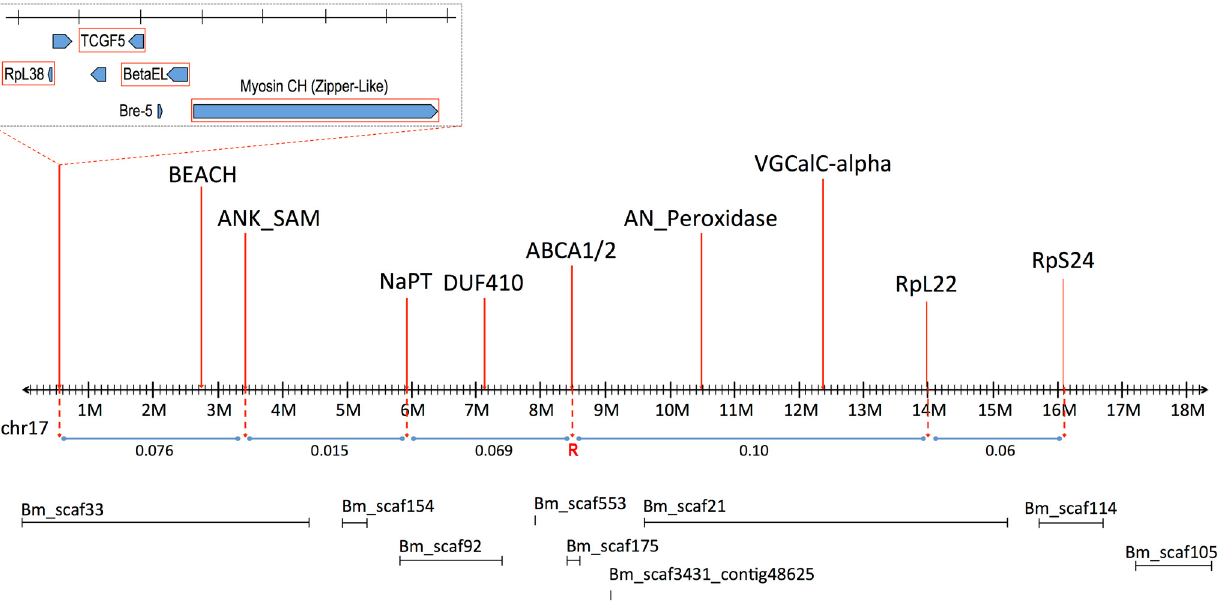
Fig 2. Linkage map of B . mori Chromosome 17 (BmChr17), showing syntenic genes used in mapping of H . armigera . Approximate recombination rates between genes are provided in relation to the putative Cry2Ab resistance gene, indicated by ‘ R ’ . The B . mori scaffolds on BmChr17 are also provided as obtained from KAIKObase < http://sgp.dna.affrc.go.jp/KAIKObase/ >